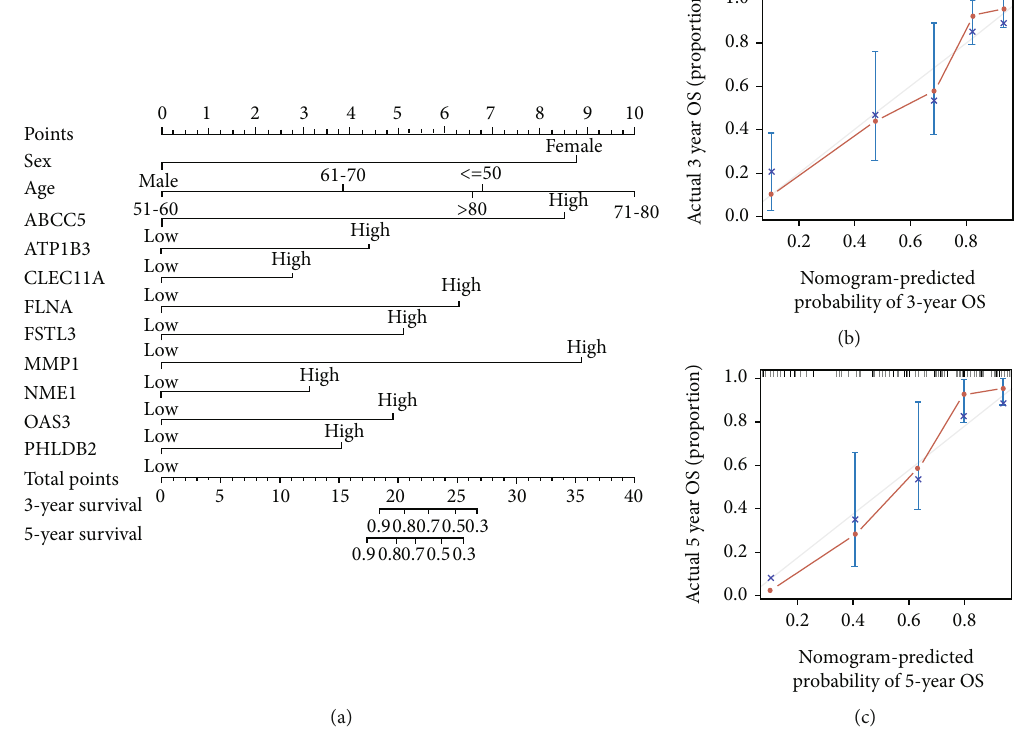
Figure 5: Construction and validation of the nomogram: (a) the nomogram using the expressions of SMPs to predict LSCC patients ’ overall survival; (b) calibration curve of the nomogram predicting 3-year overall survival rate; (c) calibration curve of the nomogram predicting 5- year overall